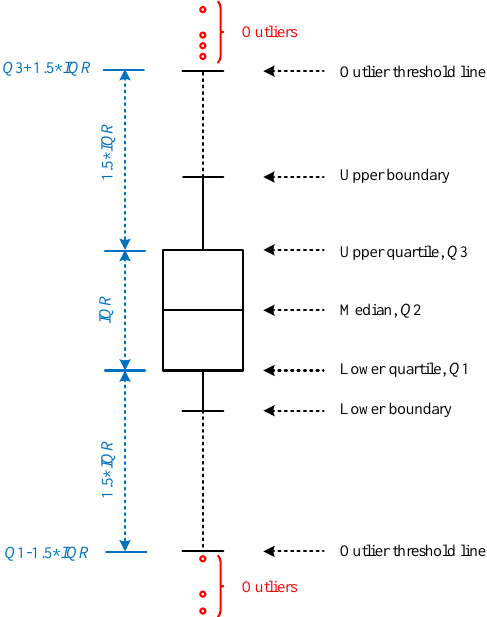
Figure 8. Schematic diagram of outlier detection using boxplot method.